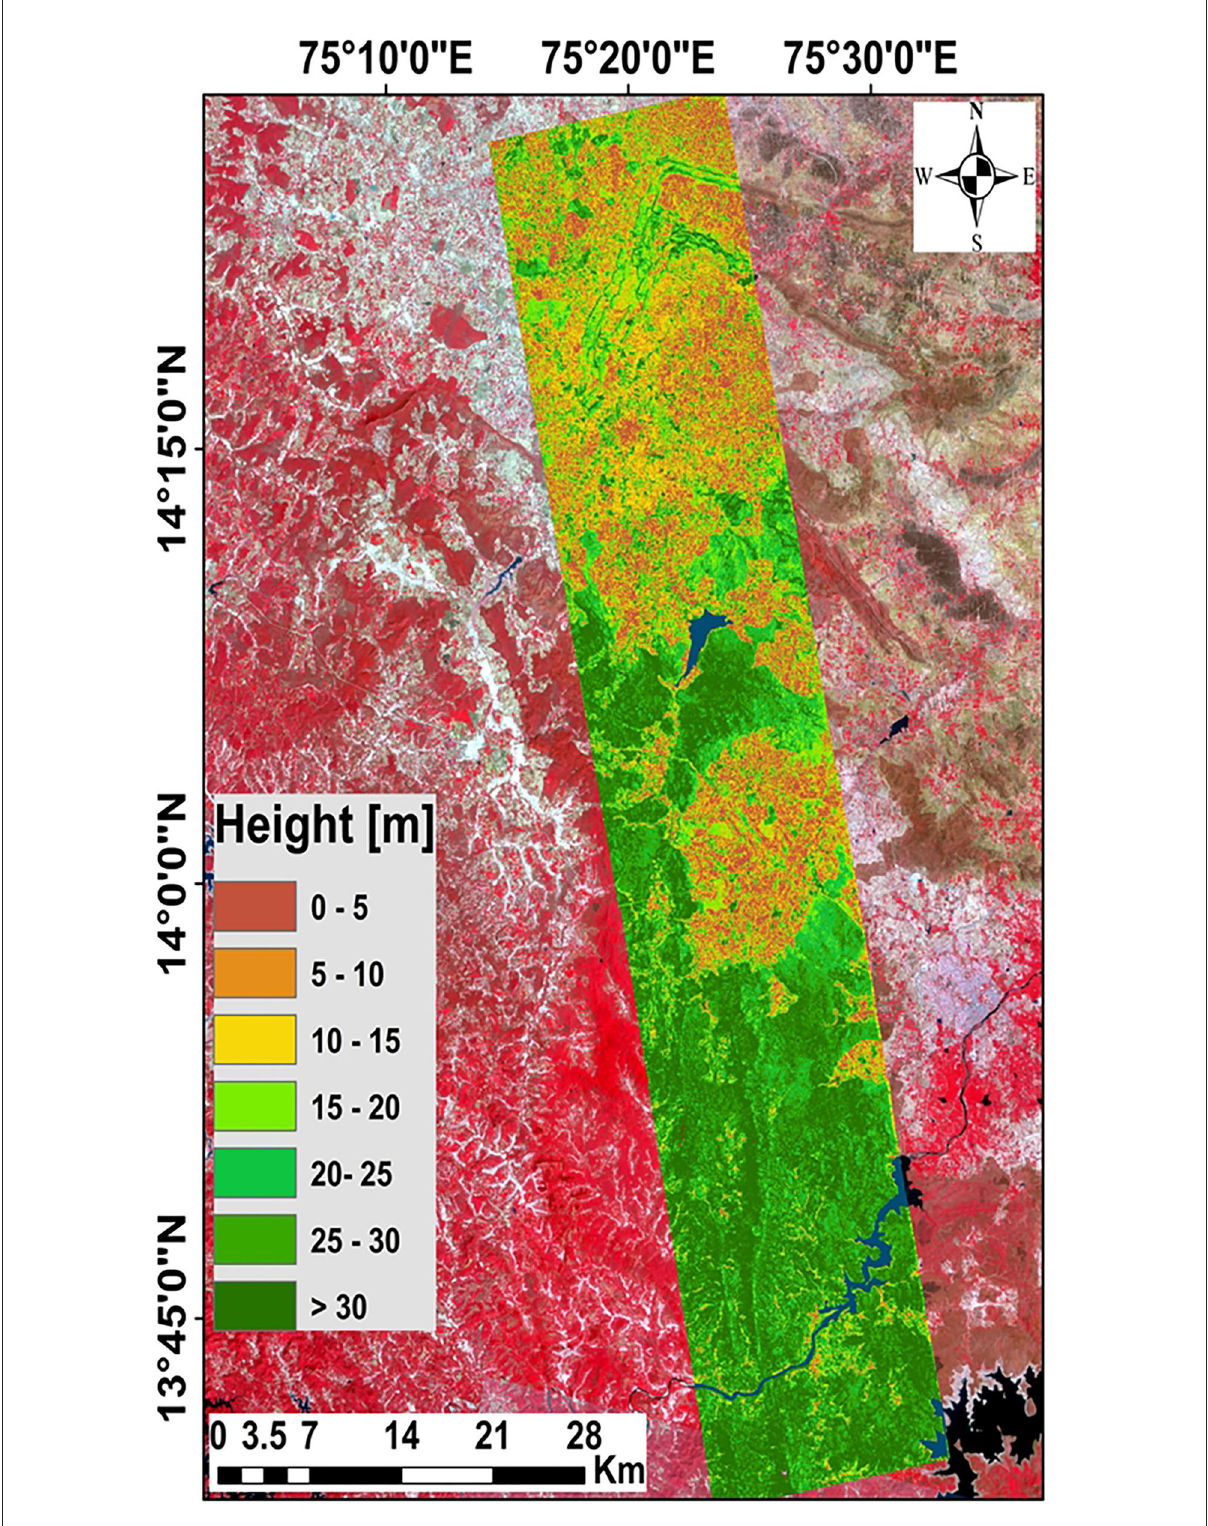
FIGURE6 Height Map for 11 December 2015 acquisition obtained after PolInSAR Inversion overlaid on Landsat 8 image. The color-bar indicates the variation in